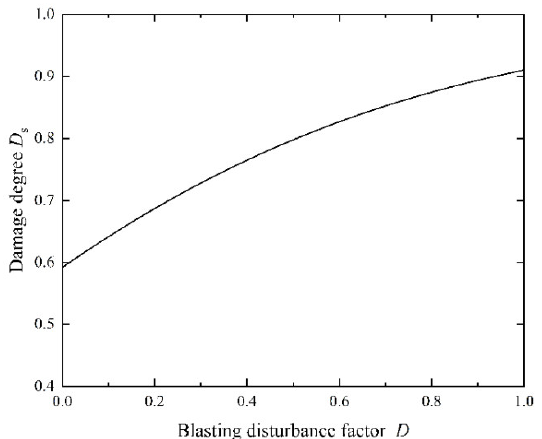
Figure 5. Curve for damage degree D s versus the disturbance factor D.